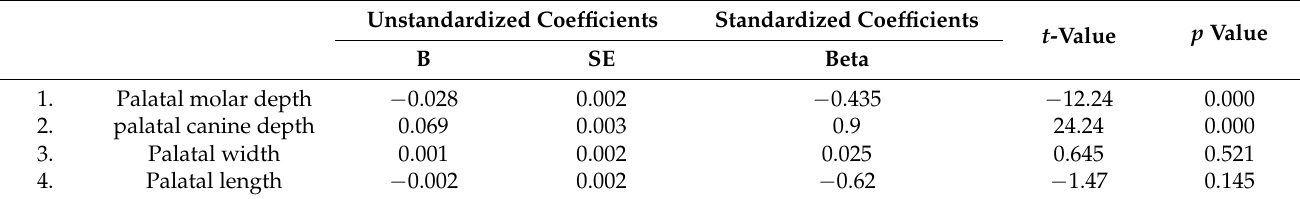
Table 6. Multiple regression analysis of arch form (as a dependent variable) and several co-variates ( n =